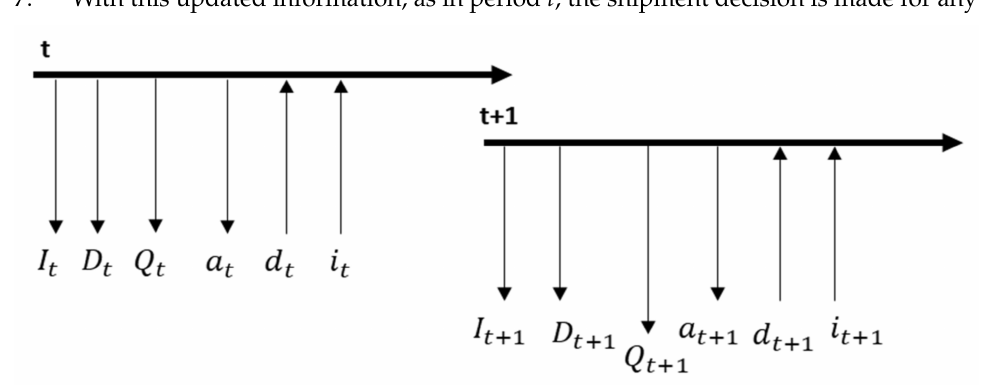
Figure 2. Sequence of events in each period in the collection center (Source: Own